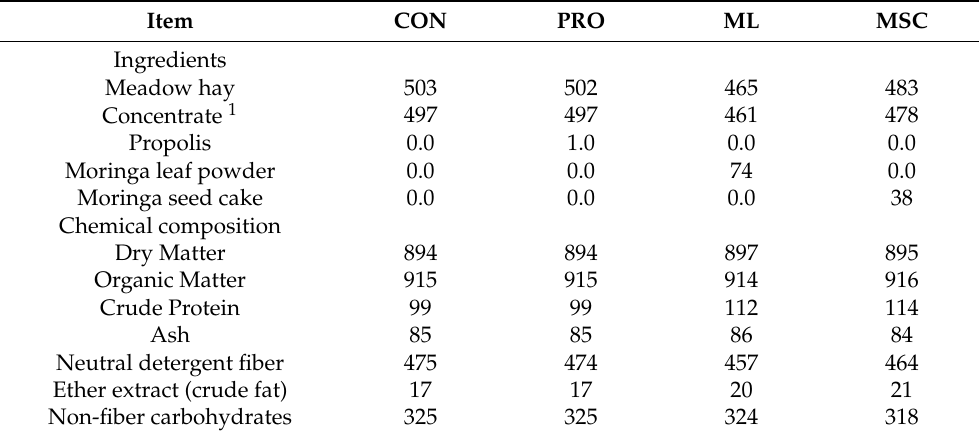
Table 1. Ingredient and chemical composition of control and experimental diets (g/kg DM) *. Item CON PRO ML